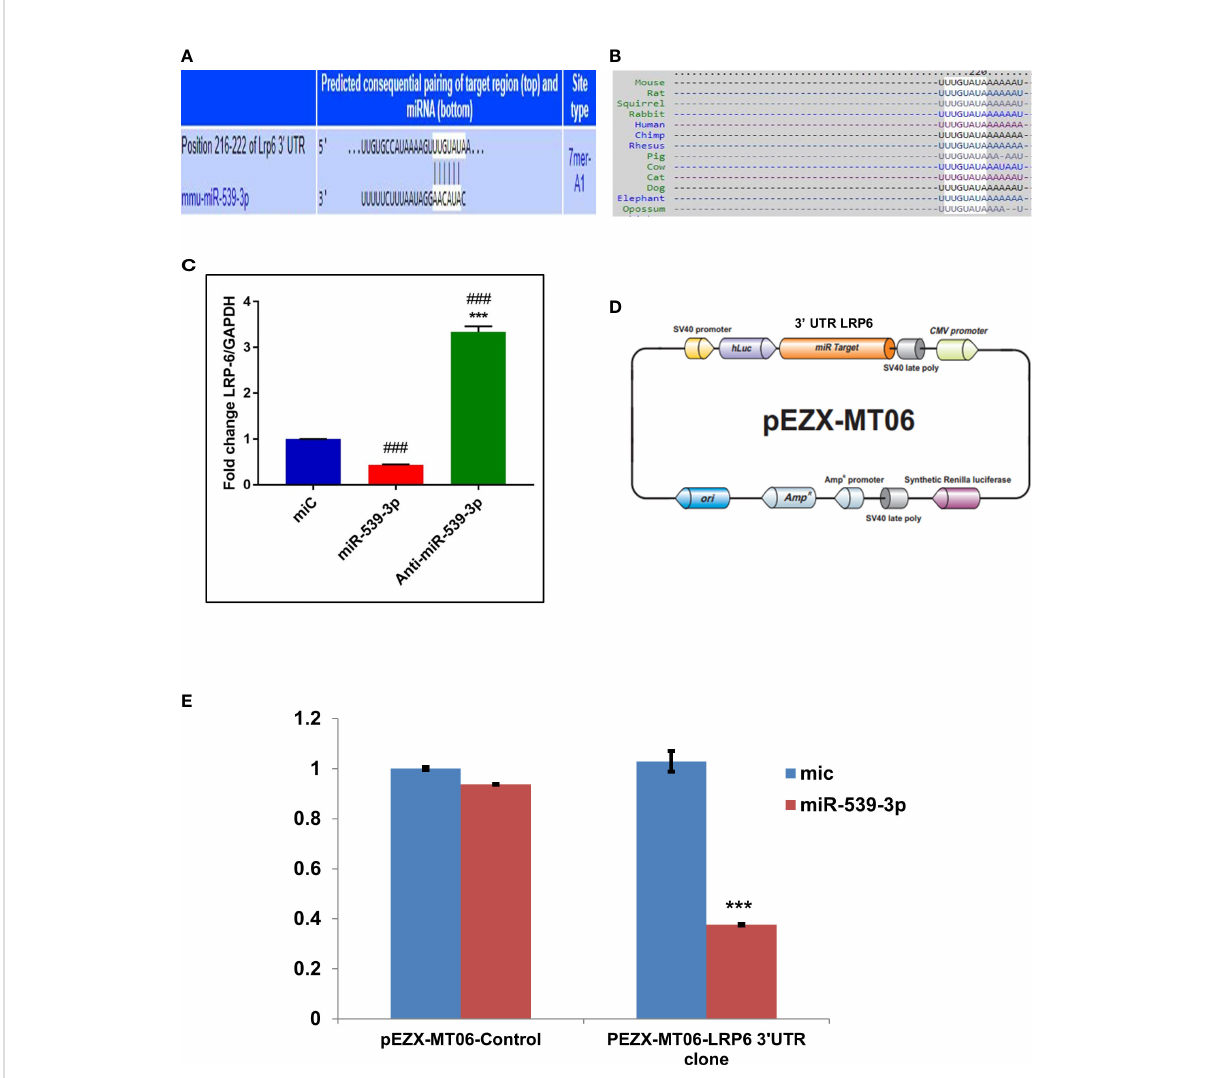
FIGURE 3 miR-539-3p target genes identi fi cation and its validation. (A) The complementarity sequences of miR-539-3p to the 3 ’ UTR of LRP-6 were evaluated using computational analysis. (B) The sequence is consistent across species. (C) The miR-539-3p expression plasmid or a control was transfected into osteoblasts. LRP-6 expression was determined using RT-PCR. GAPDH was employed as an internal control. All data represent mean ± S.E. (n = 6). ***P < 0.001 compared with the control, ### P< 0.001 compared with miR-539-3p. (D) Schematic presentation of the reporter plasmid used to demonstrate the impact of LRP-6 3 ’ UTR on luciferase activity. (E) miR-539-3p over-expression ’ s effect on a dual luciferase reporter plasmid carrying the LRP-6 3 ’ UTR was analyzed. Cells were co-transfected with miR-539-3p or miC and either the pEZXMT06 control or LRP-6 3 ’ UTR clones. In cell lysate, fi re fl y and renilla luciferases were quanti fi